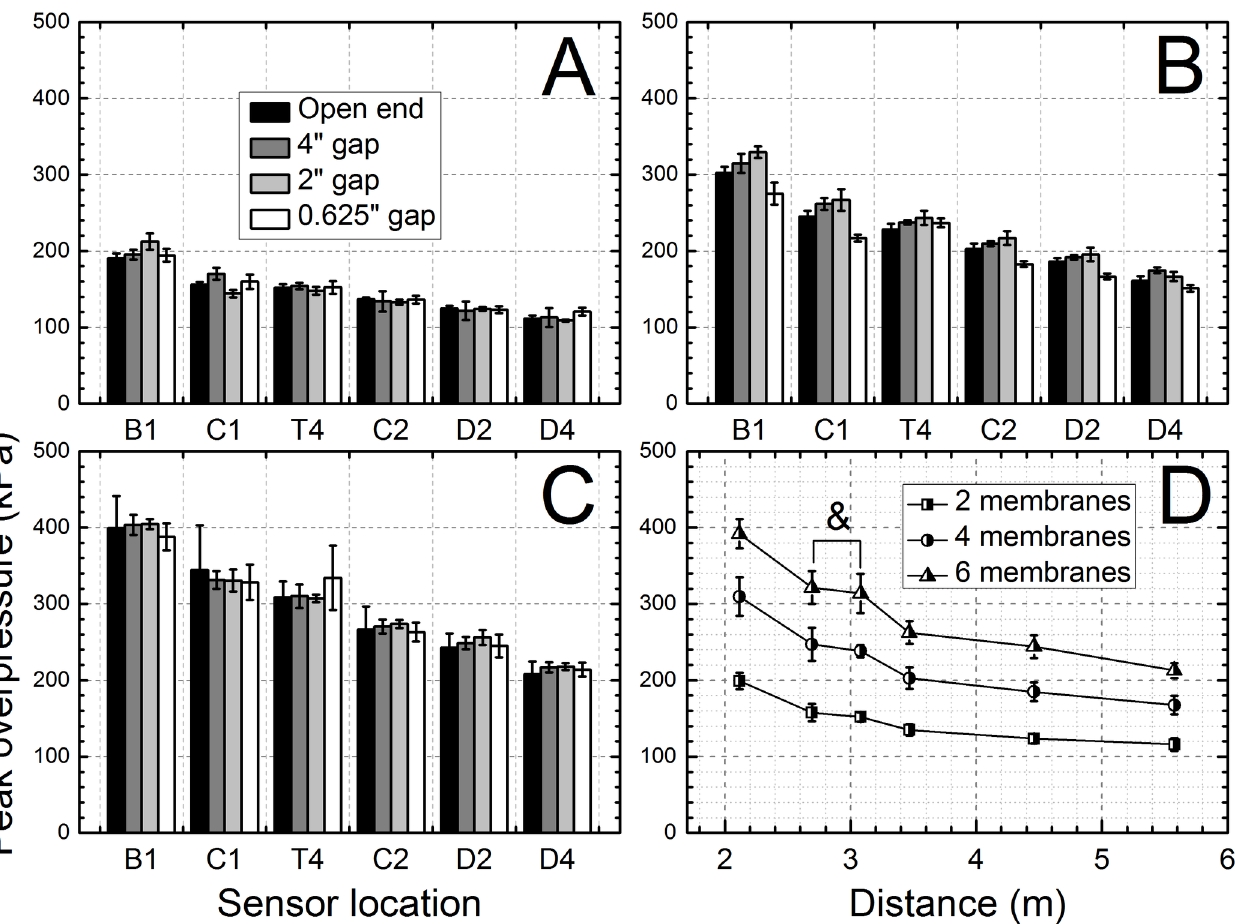
Fig 2. Peak overpressure inside of the shock tube as a function of sensor location and membrane thickness: A) 0.02 ” , B) 0.04 ” , and C) 0.06 ” . Peak overpressure values averaged among experiments preformed using the same Mylar membrane thickness (D): differences of average BOPs for sensors C1 and T4 are not statistically significant (marked with ampersand & , p > 0.05) in respective test